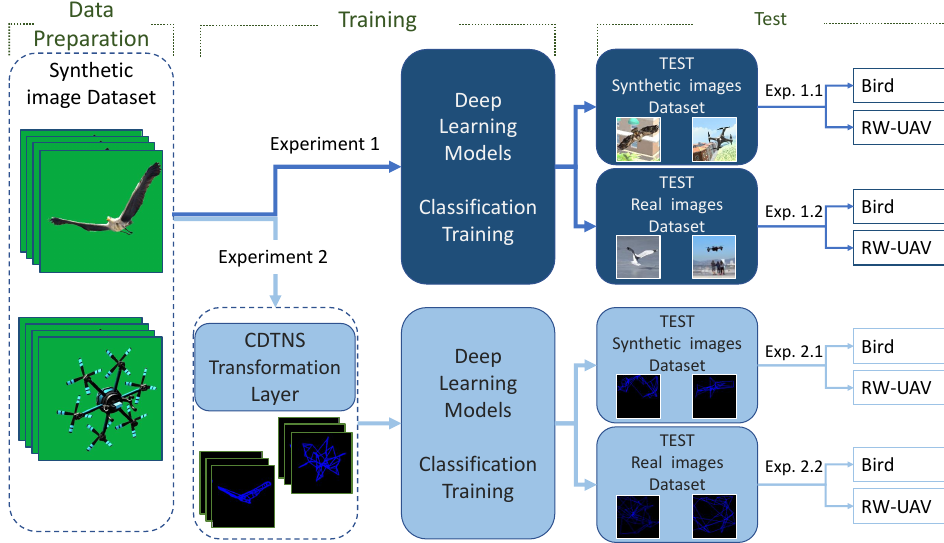
Figure 1. Schematic representation of data preparation ( left ), network training ( middle ) and testing ( right ) process for experiment 1 ( top ) and experiment 2 ( down